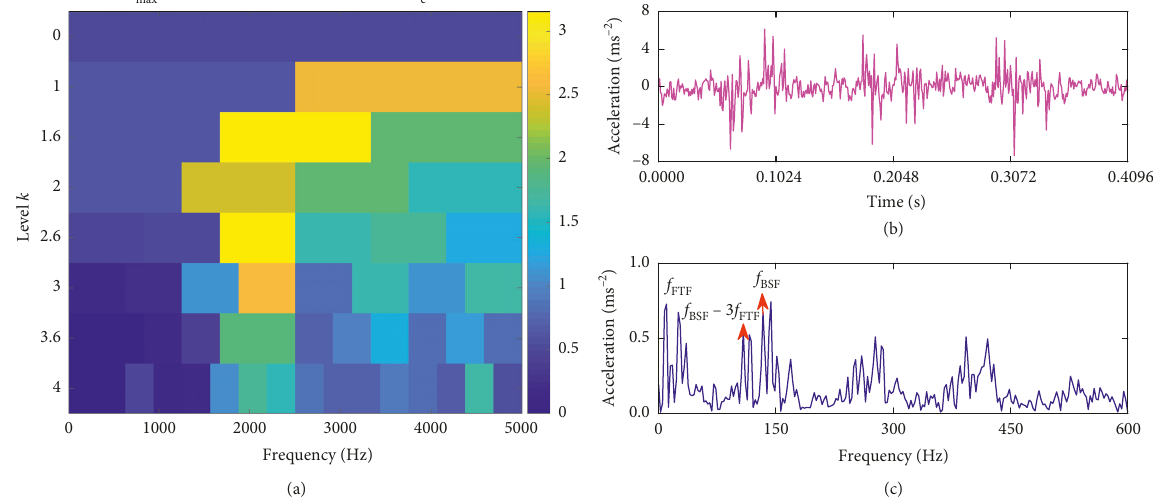
Figure 39: Results obtained using (a) spectra kurtosis: (b) purified signal; (c) Hilbert envelope spectra.